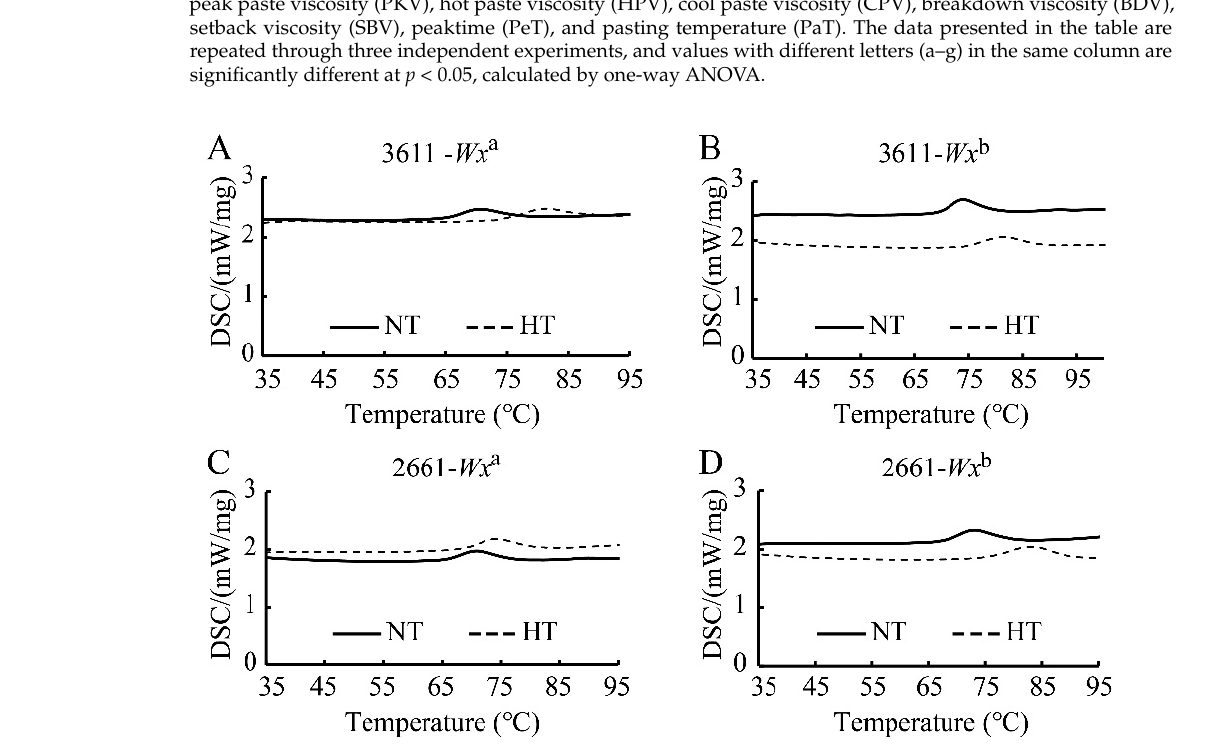
Figure 6. The influence of high temperature on the gelatinization features of Wx NILs with 3611 ( A , B ) and 2661 ( C , D ) genetic backgrounds. “NT” stands for normal condition and “HT” stands for high-temperature condition. Table 1. RVA analysis of different Wx NILs planted under different temperature conditions.